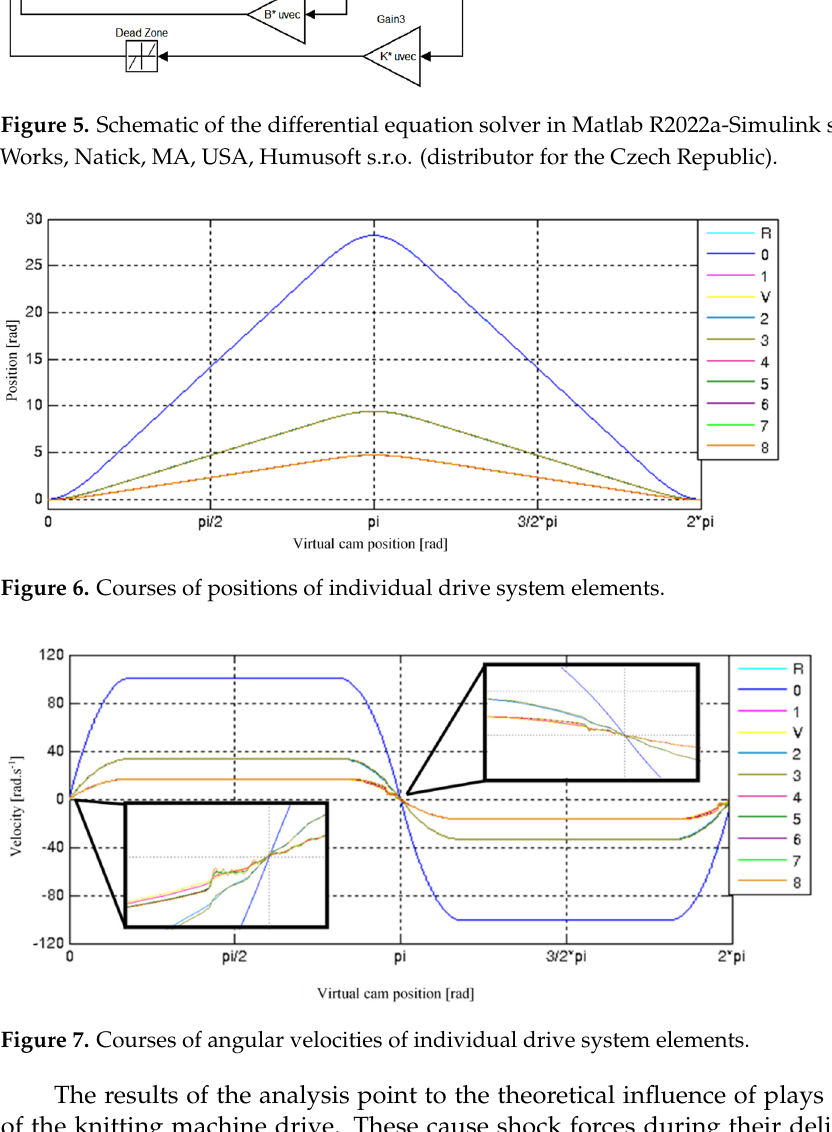
Figure 8. Courses of angular accelerations of individual drive system elements.